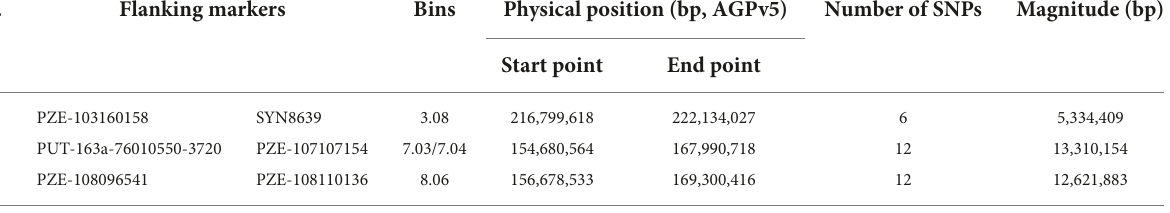
TABLE 2 Three candidate Ht3 -like regions associated with NCLB resistance. Chr.